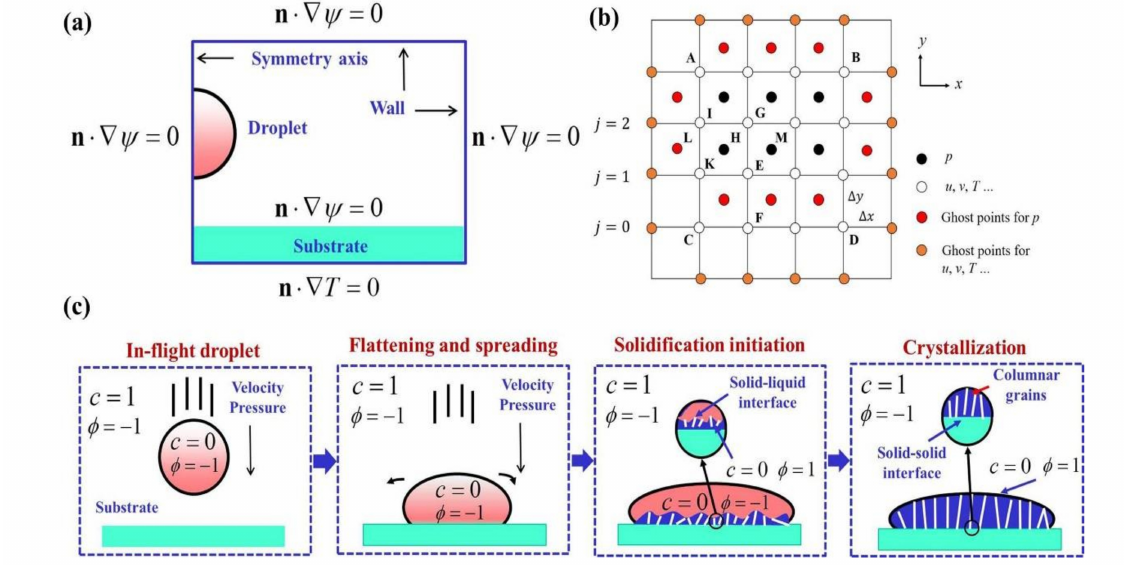
Figure 3. Parameters definition of calculation process: ( a ) boundary conditions; ( b ) a modified grid during discretization; ( c ) order parameter distribution of droplet after impacting on the